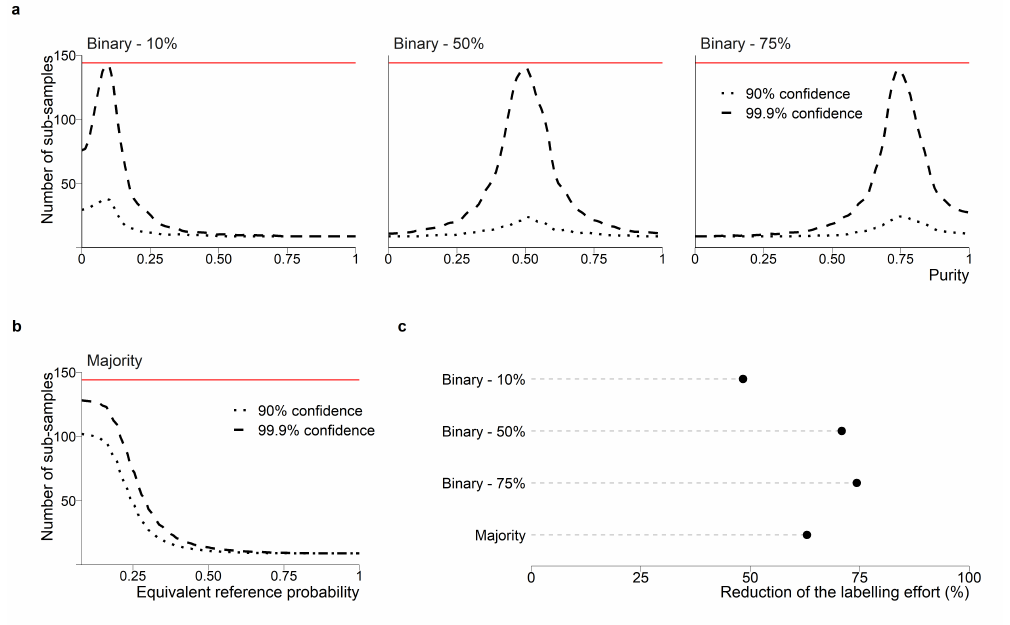
Figure 6. Effect of optimizing the number of sub-samples on the labeling effort and the error rate using different confidence levels for threshold-based ( a ) and majority-based classification system ( b) . The red line indicates the amount of sub-samples collected without optimisation (144 sub-samples). The proposed method markedly reduces the number of sub-samples in all cases ( c